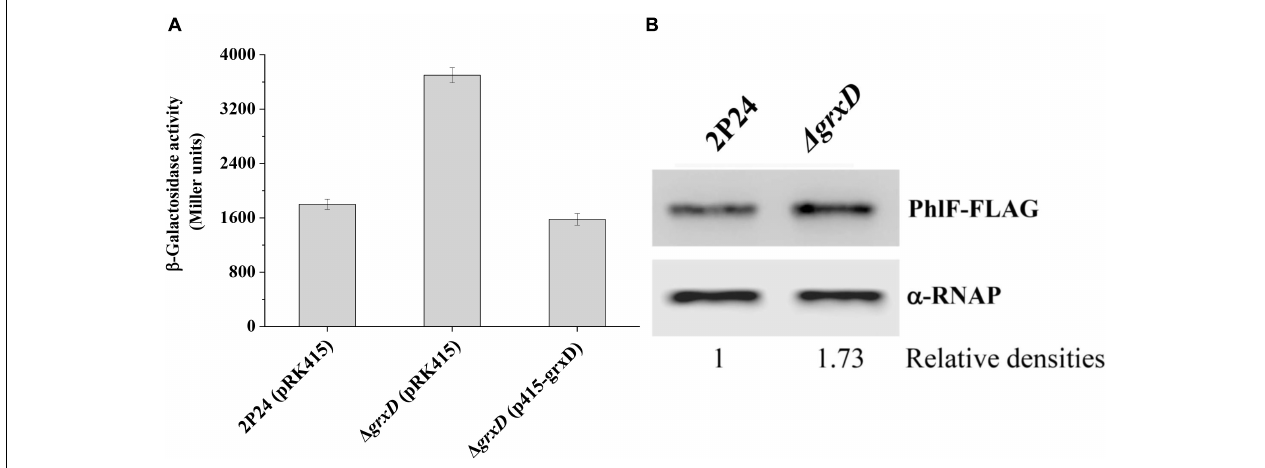
FIGURE 3 | GrxD influenced phlF in Pseudomonas fluorescens . (A) The β -galactosidase activity of phlF - lacZ transcriptional fusion was determined in strains 2P24 (pRK415), the grxD mutant (pRK415), and the grxD mutant (p415-grxD). (B) Western blot analysis was performed to detect the level of PhlF-FLAG. The relative intensities of PhlF-FLAG bands were marked below the blot. All experiments were performed in triplicate, and different letters indicate a significant difference at the 0.05 level.